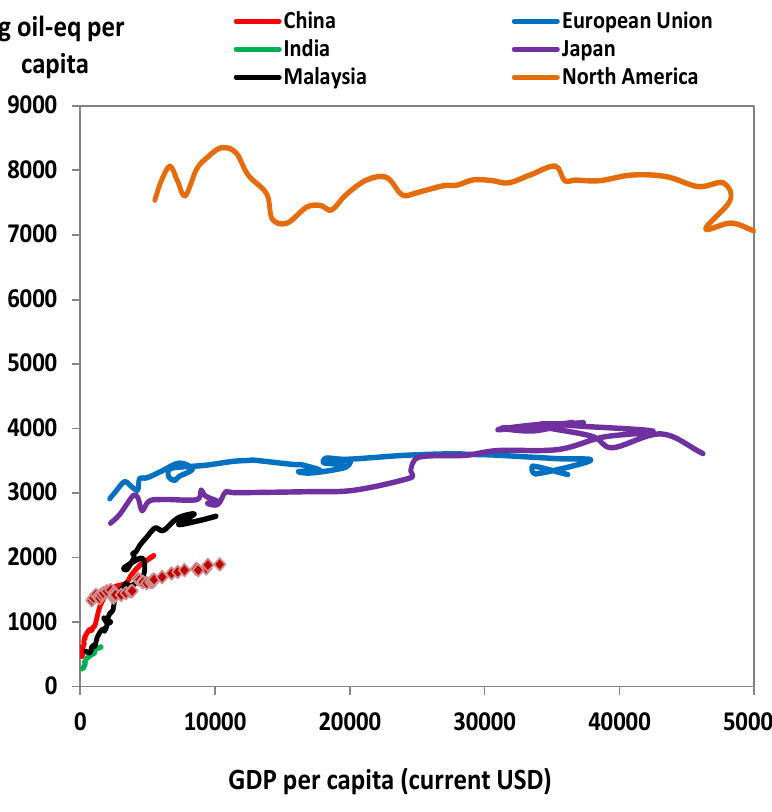
Figure 6. Chart depicts annual per capita primary energy consumption as a function of GDP (at current USD) per capita, from 1971 to 2011. The graph illustrates that although the link between GDP growth and energy use is strong, there are developmental pathways that lead to GDP growth but with a more modest increase in rate of energy consumption. Data were obtained from the World Bank [38] and plotted by the